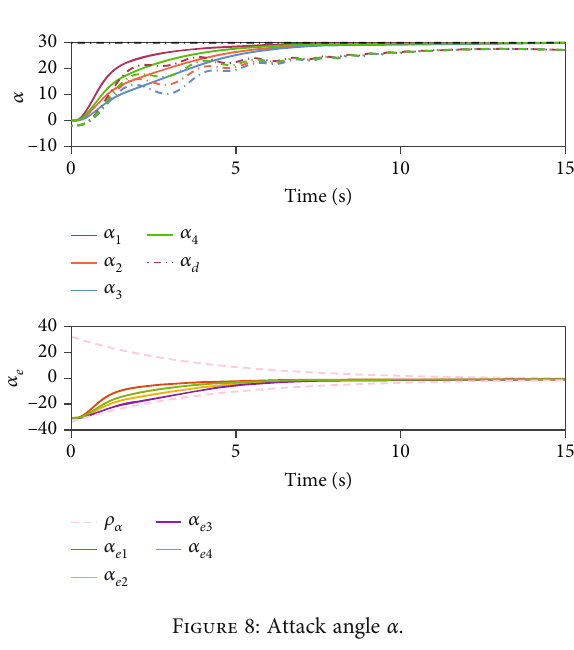
Figure 7: Roll angle ϕ .